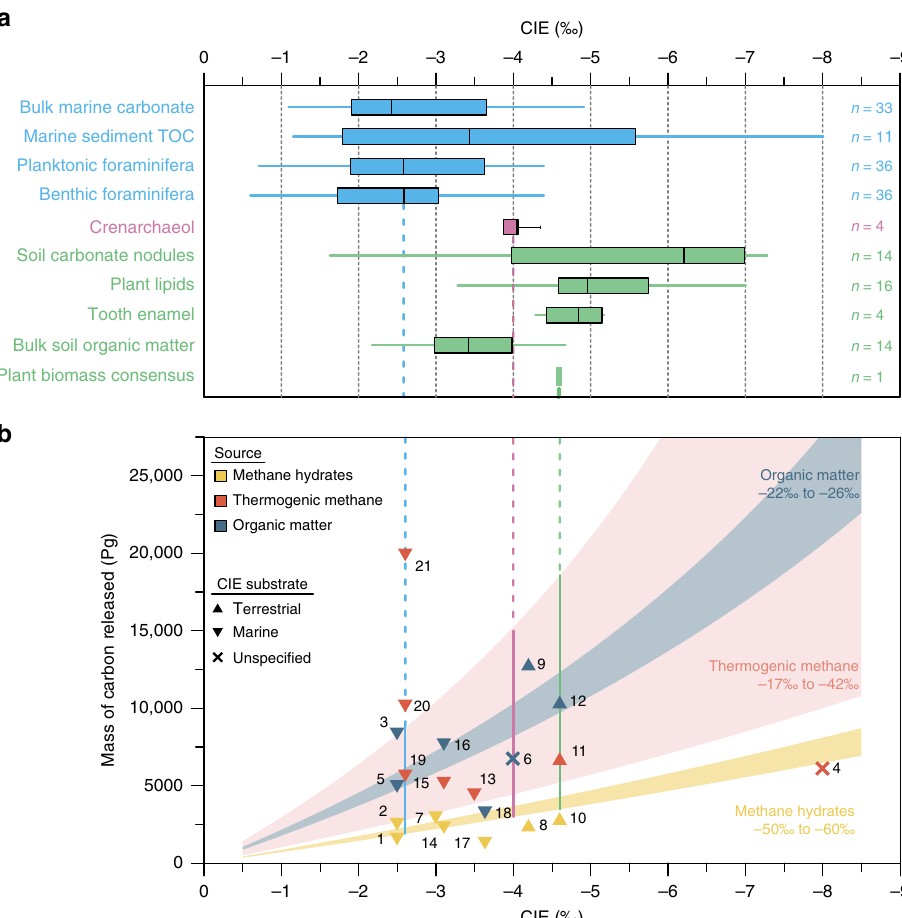
Fig. 3 Estimates of the carbon isotope excursion and corresponding emission scenarios during the Paleocene-Eocene Thermal Maximum. a Carbon isotope excursion (CIE) magnitude for the Paleocene-Eocene Thermal Maximum (PETM) reconstructed from crenarchaeol at our three study sites and one additional site from the North Sea, alongside estimates from other substrates of marine (blue) or terrigenous origin (green) compiled previously 16 (TOC: total organic carbon). Whiskers indicate maximum/minimum values, boxes represent the 25 and 75% quartiles, and the horizontal line identi fi es the median. b Compilation of published PETM emission scenarios with reported CIE value and estimate of total carbon emissions (numbers refer to information listed in Supplementary Data 1; note that studies with multiple scenarios are tabulated and shown in this fi gure as separate entries), which are superimposed on a parameter space of the δ 13 C of the emission carbon source (color shading) de fi ned by the CIE magnitude and the mass of carbon emitted; assuming a fi xed mass (40,000 Pg C) 71 and isotopic composition ( δ 13 C = − 2.5 ‰ ) 78 of the exogenic carbon reservoir. Symbols denote the sample substrate on which the CIE was measured, and color coding indicates the assumed source of carbon in each emission scenario. Vertical bars represent median CIEs recorded in crenarchaeol (this study and ref. 31 ), benthic foraminifera 16 , and a plant biomass consensus estimate